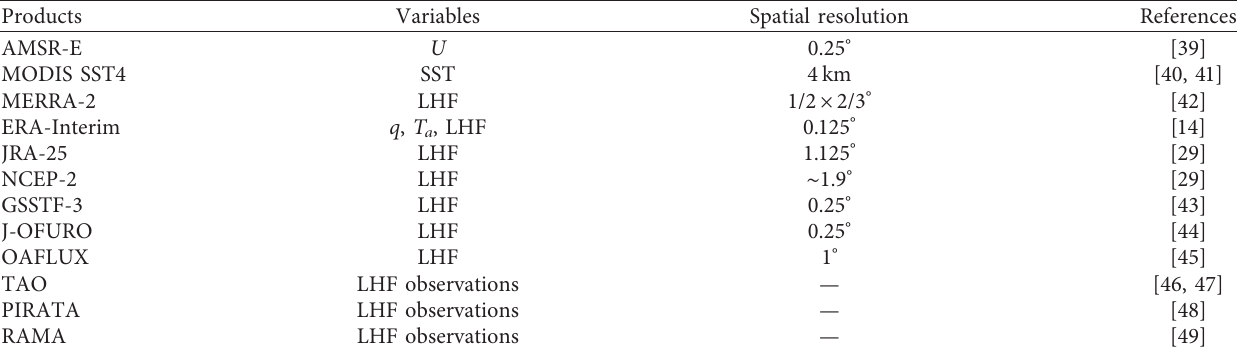
Table 1: Summary of the forcing input variables, seven ocean LHF products, and three groups of buoy observations.